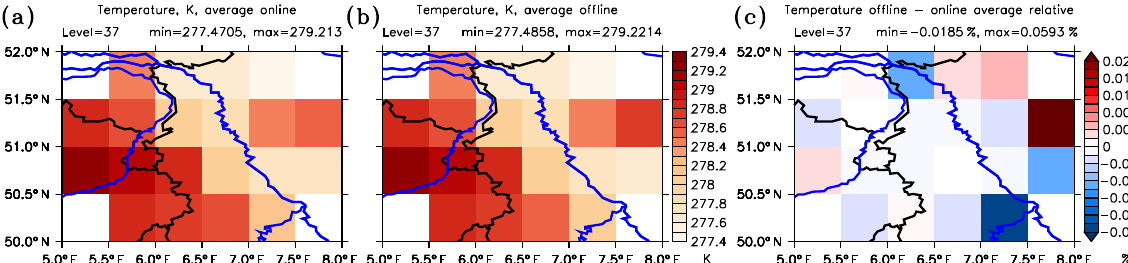
Figure 2. Temperature on 24 April 2013, 01:00:00UTC simulation time on model level 37 (approx. 1800m) averaged on the 0.5 ◦ × 0.5 ◦ grid. (a) Output of online calculation from GRAGG, (b) offline calculation from 3-D ICON model output, (c) relative difference between offline and online calculated values. For orientation note the country borders in black and larger rivers in blue.